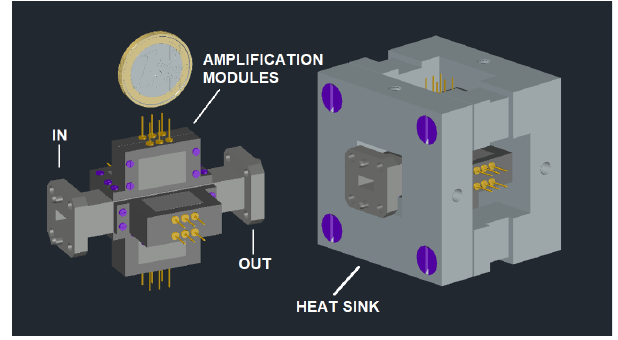
FIGURE 8. Drawings of the innovative SPC. Note the SPC size respect 1 Euro coin.